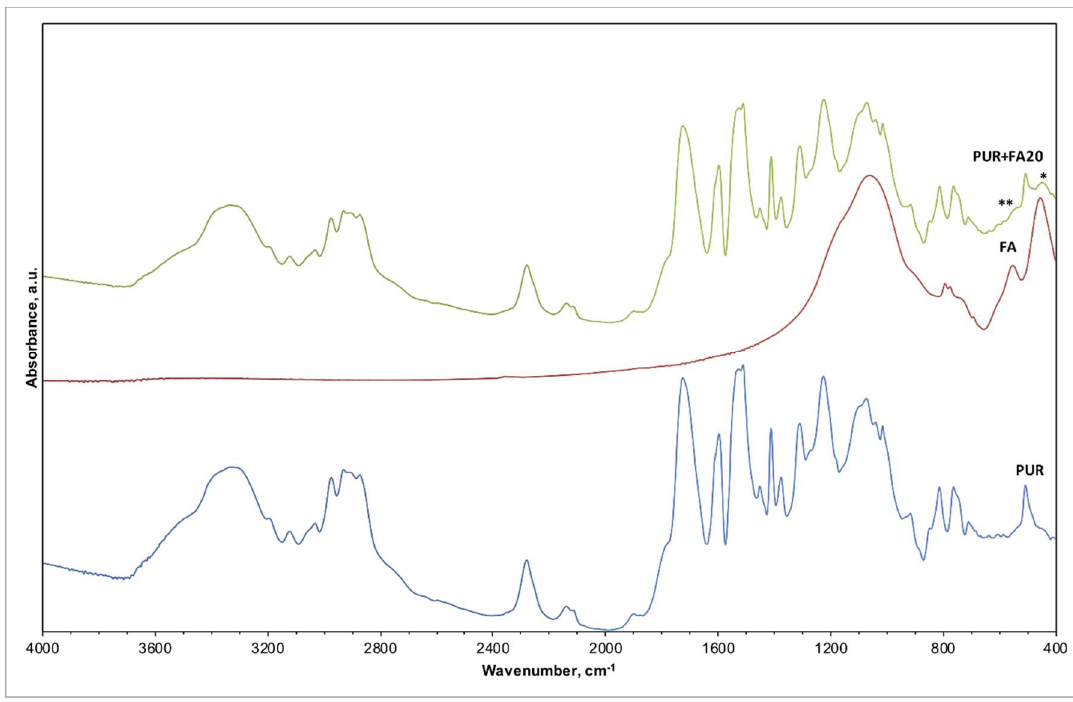
Figure 5. IR spectra of PUR foam, FA, and PUR foam modified with 20 wt.% of FA (PUR + FA20p).